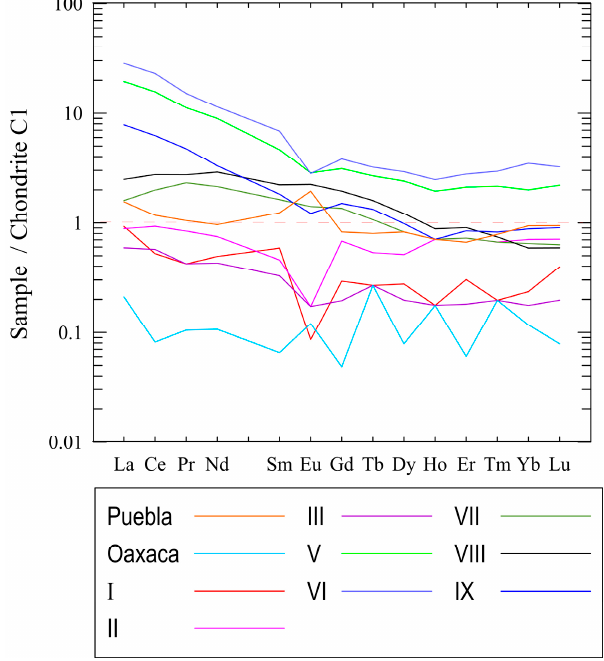
Figure 8. Concentrations of the elements of the lanthanide group in different type of talc normalized to a chondrite C1 [36].